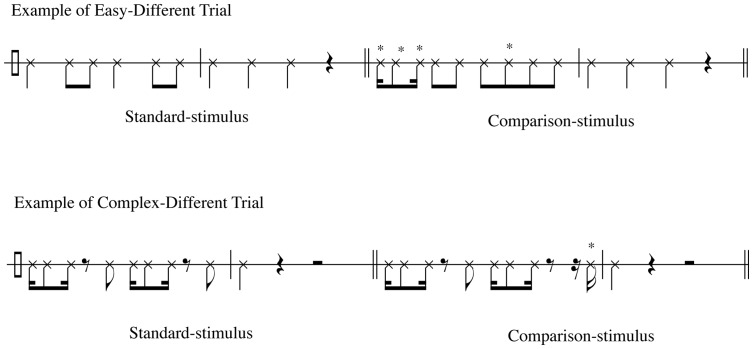
Example from the standard rhythm trials.An easy trial consists of a simple rhythm (mostly quarter notes and eighth notes), as compared with a complex trial, which consists of a more complicated rhythm (eighth notes and sixteenth notes). *Represents the alteration in the comparison-stimuli.